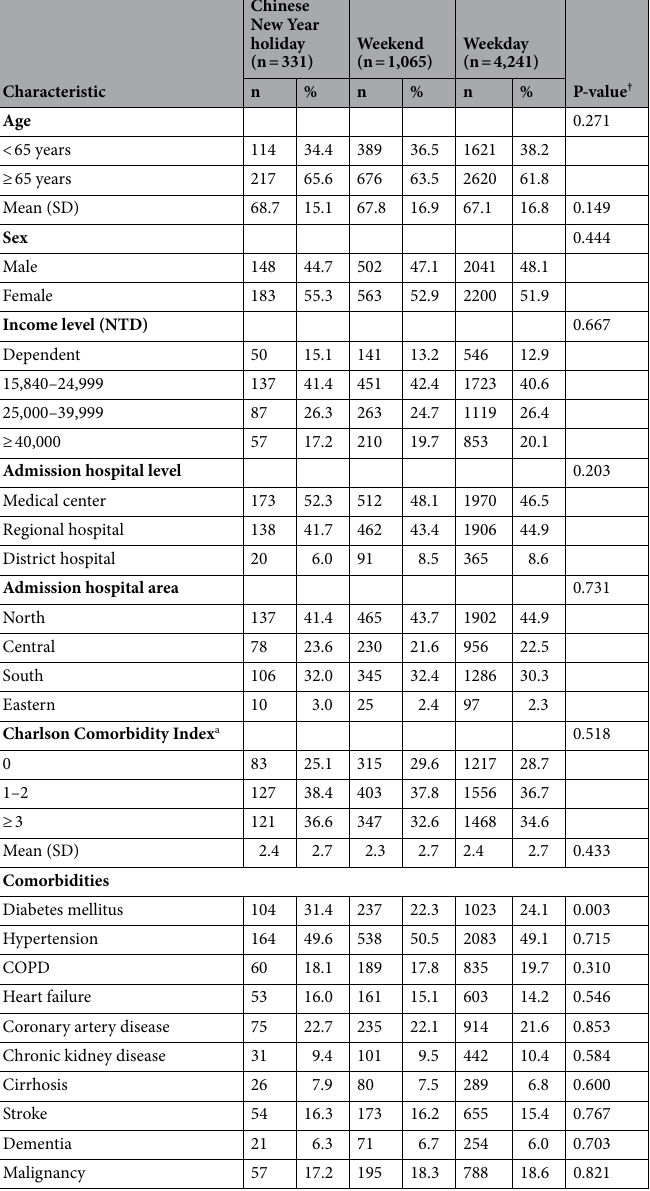
SD standard deviation. † Categorical variables were compared using the chi-squared test and continuous variables using analysis of variance. a Calculated without including scores for